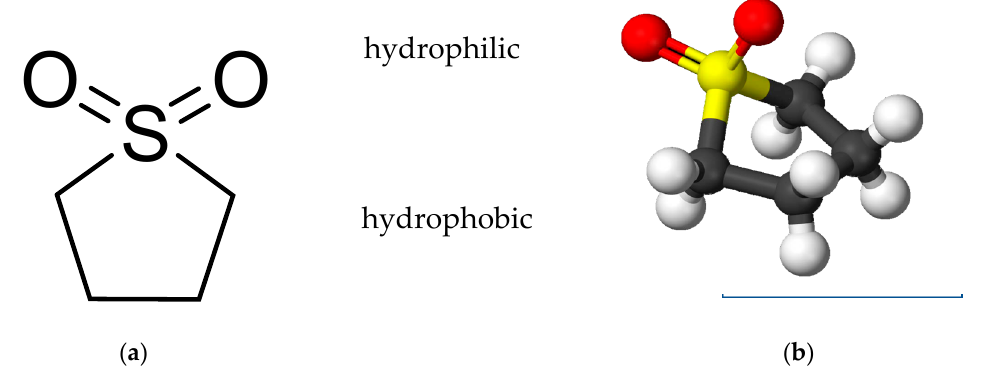
Figure 1. Structure of sulfolane with ( a ) hydrophilic and hydrophobic parts and ( b ) 3D geometry.